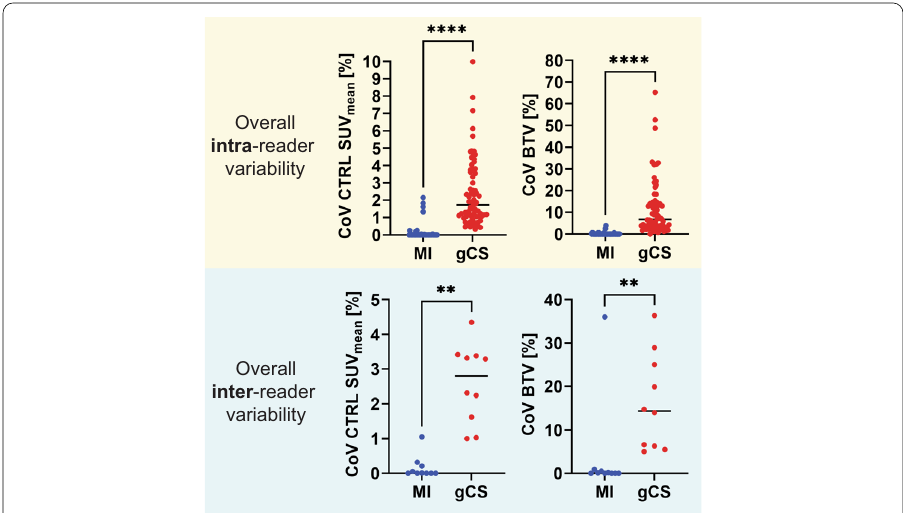
Fig. 3 Summary plots of intra-reader and inter-reader coefficient of variation (CoV) for the overall group. The plots show the comparison of the intra-reader and inter-reader CoV of the CTRL SUV mean (top row) and BTV (bottom row) between the MI (blue) and the gCS (red) methods for the overall group of readers. * p < 0.05, ** p < 0.01, *** p < 0.001, **** p < 0.0001, ns no significant difference. BTV = volume; CoV coefficient of variation; CTRL contralateral background reference region; gCS = = crescent-shape; MI mirror-image; SUV standard uptake = =